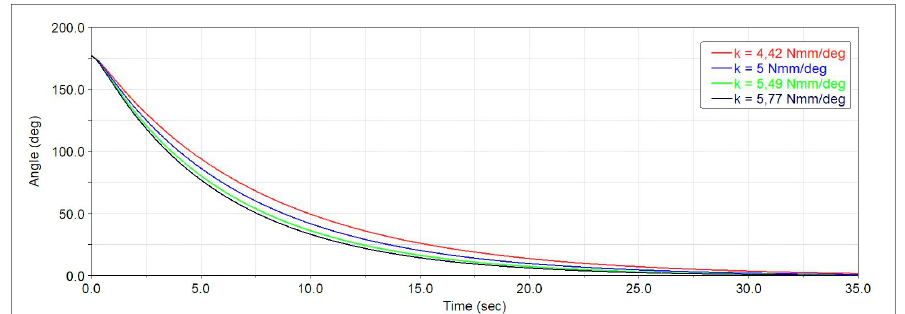
Figure 14. Spring-damper system angle of the first cell as a function of the simulation time and when the stiffness coefficient varies from 4.42 to 5.77 N · mm/deg.